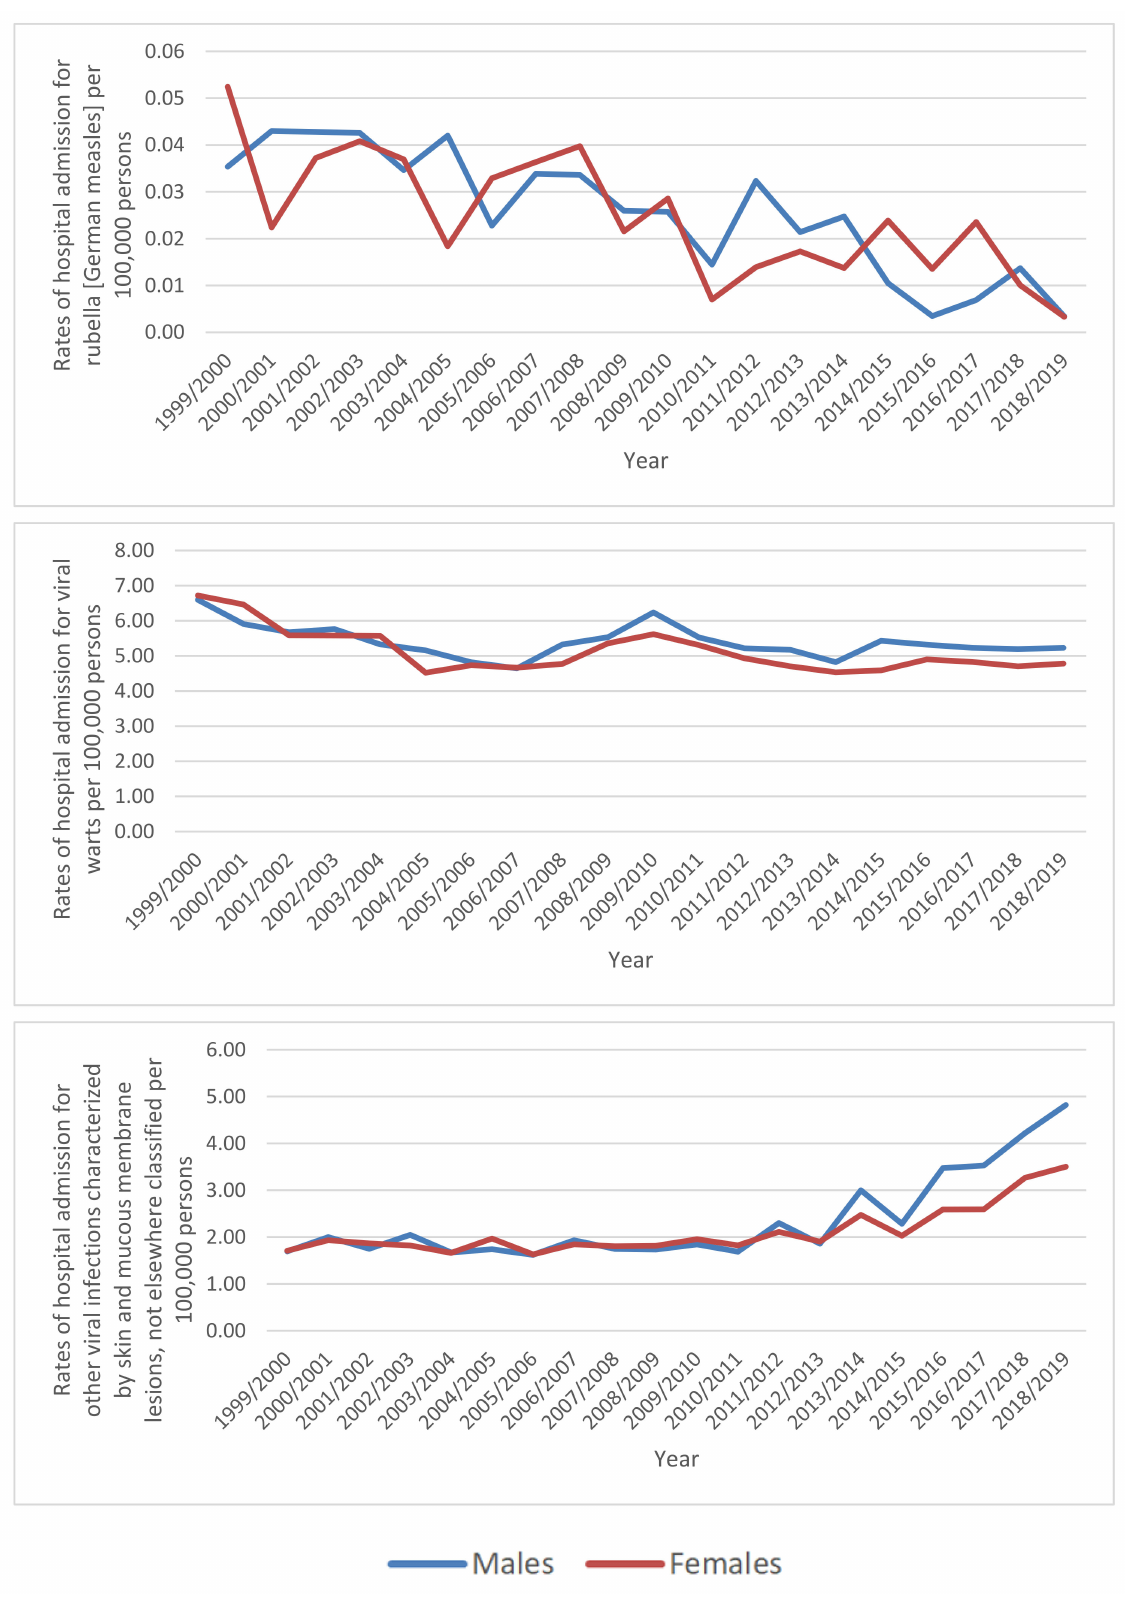
Figure 4. Hospital admission rates in England and Wales stratified by